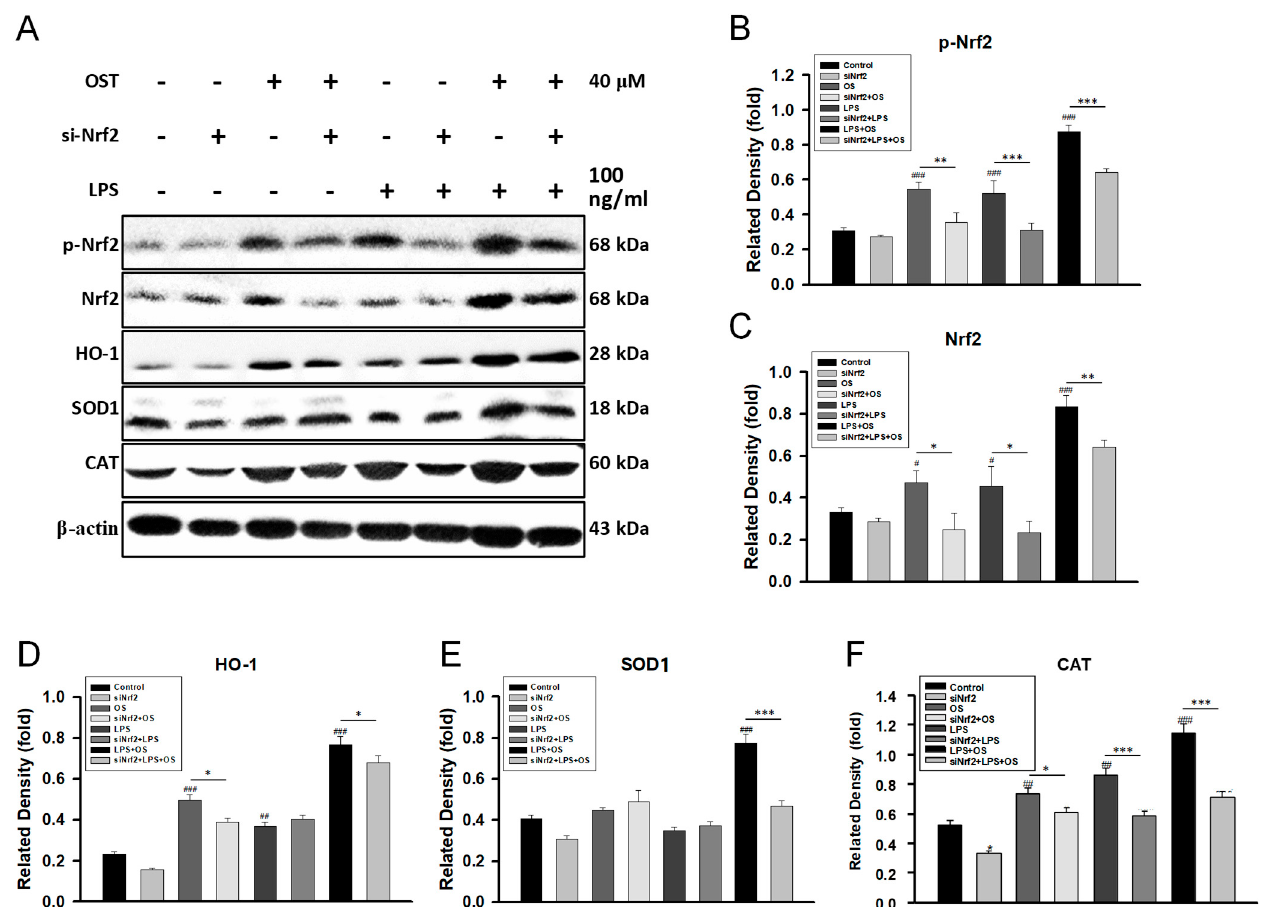
Figure 1. OST activated the Nrf2/HO-1 signaling pathway, but it was reversed by the Nrf2 siRNA transfection in BV2 cells. ( A ) Mock (control) or Nrf2 siRNA were transfected into BV2 cells. Cells were treated with 40 µ M OST for 1 h before being stimulated with LPS for 24 h. The protein expressions were analyzed with a western blot assay. The expression of related proteins, including ( B ) p-Nrf2, ( C ) Nrf2, ( D ) HO-1, ( E ) SOD1, and ( F ) CAT were shown individually. All results were expressed as folds mean ± SEM compared with β -actin of three independent experiments (n = 3). # p < 0.05, ## p < 0.01 ### p < 0.001 compared with the control (mock) group; * p < 0.05, ** p < 0.01, and *** p < 0.001 compared with the counterpart of the mock-treated group.